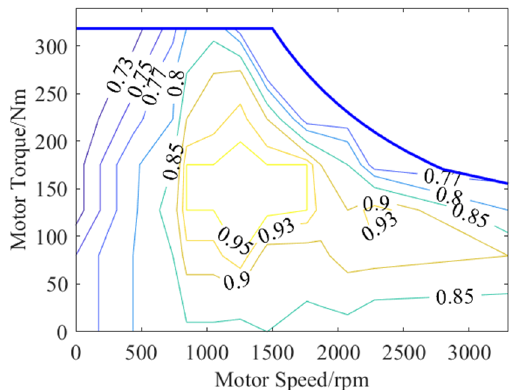
Figure 4. Rotor motor efficiency map.